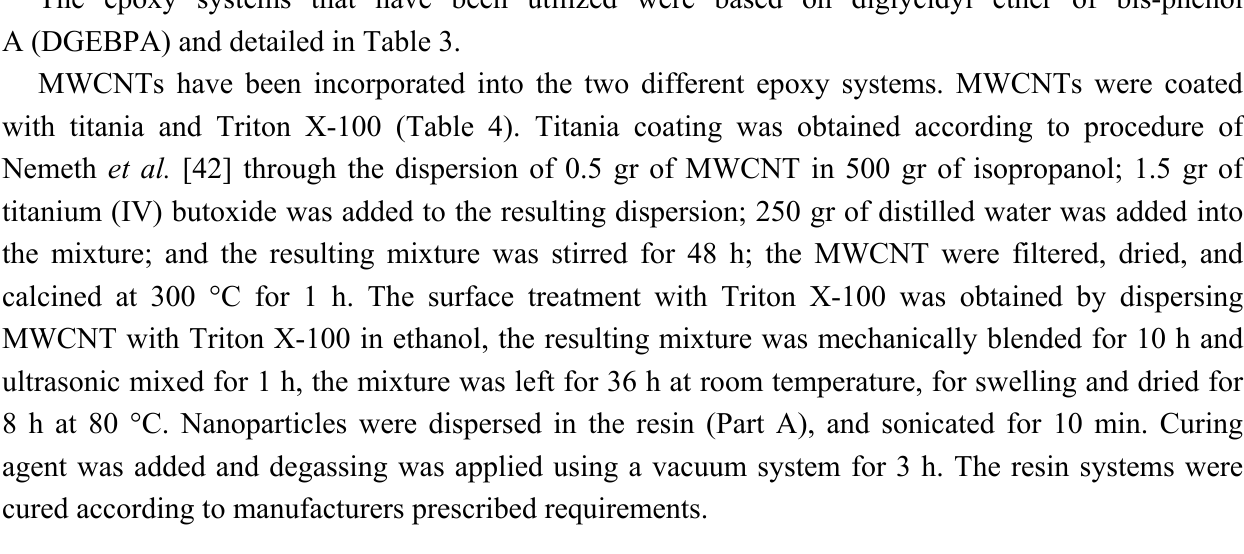
Table 4. List of materials